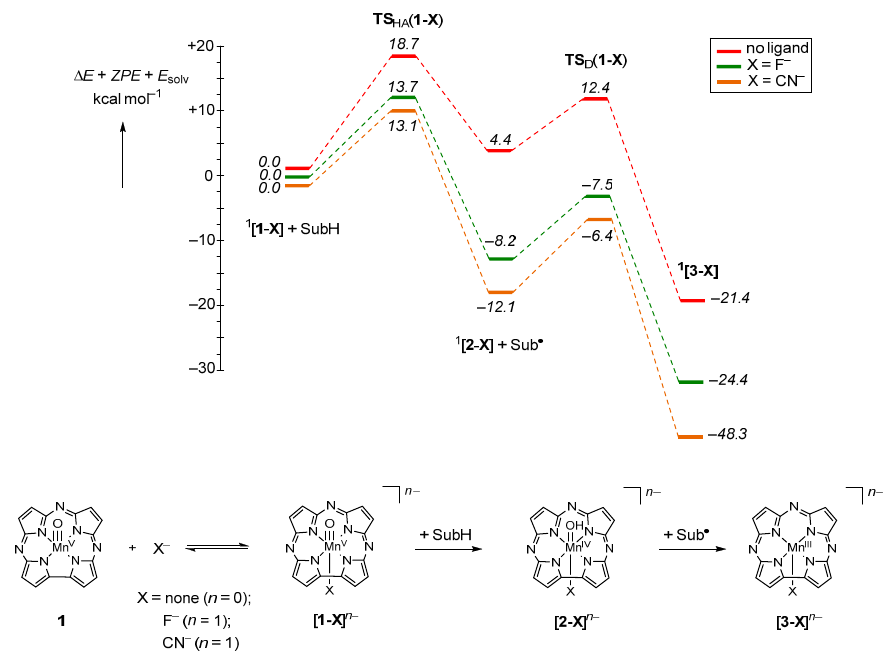
Figure 6. Catalytic mechanism of axial ligand binding and the subsequent dehydrogenation of substrate (9,10-dihydroanthracene) to water and anthracene. Energies are Δ E + ZPE values in kcal·mol − 1 as calculated with B3LYP. Data taken from [80].